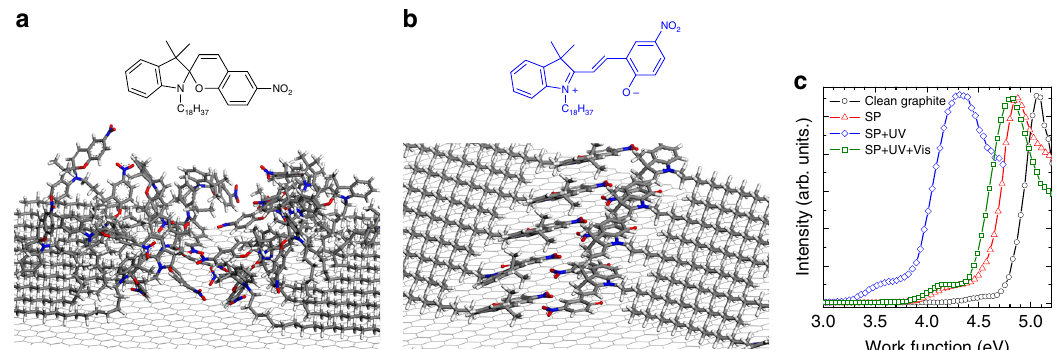
Fig. 2 Calculated assemblies and measured evolution of the substrate work function. a Representative snapshot of the calculated dynamic evolution of the spiropyran (SP) assembly. b Self-assembly of the merocyanine (MC) isomer. The positively charged region is lifted up. c Evolution of the work function of highly oriented pyrolytic graphite as a consequence of the isomerization of the photochromic assembly experimentally measured by ultraviolet photoemission spectroscopy. Such evolution of the work function can be fully explained on the basis of the (average) orientation of the vertical